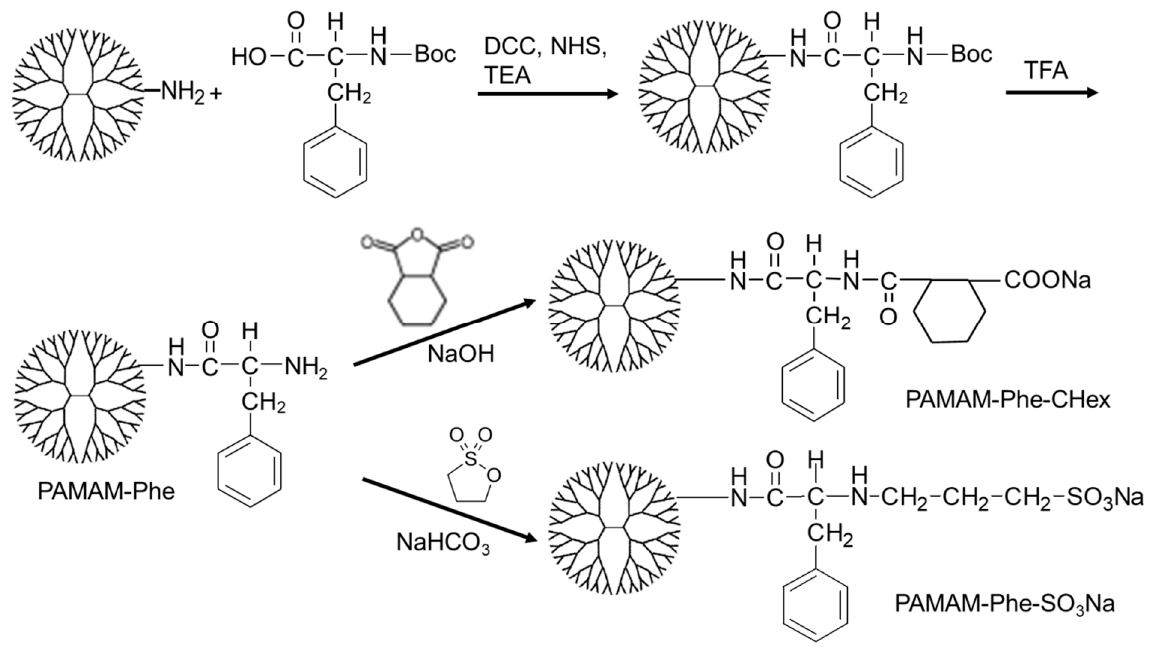
Figure 2. Synthetic scheme of PAMAM-Phe-CHex and PAMAM-Phe-SO 3